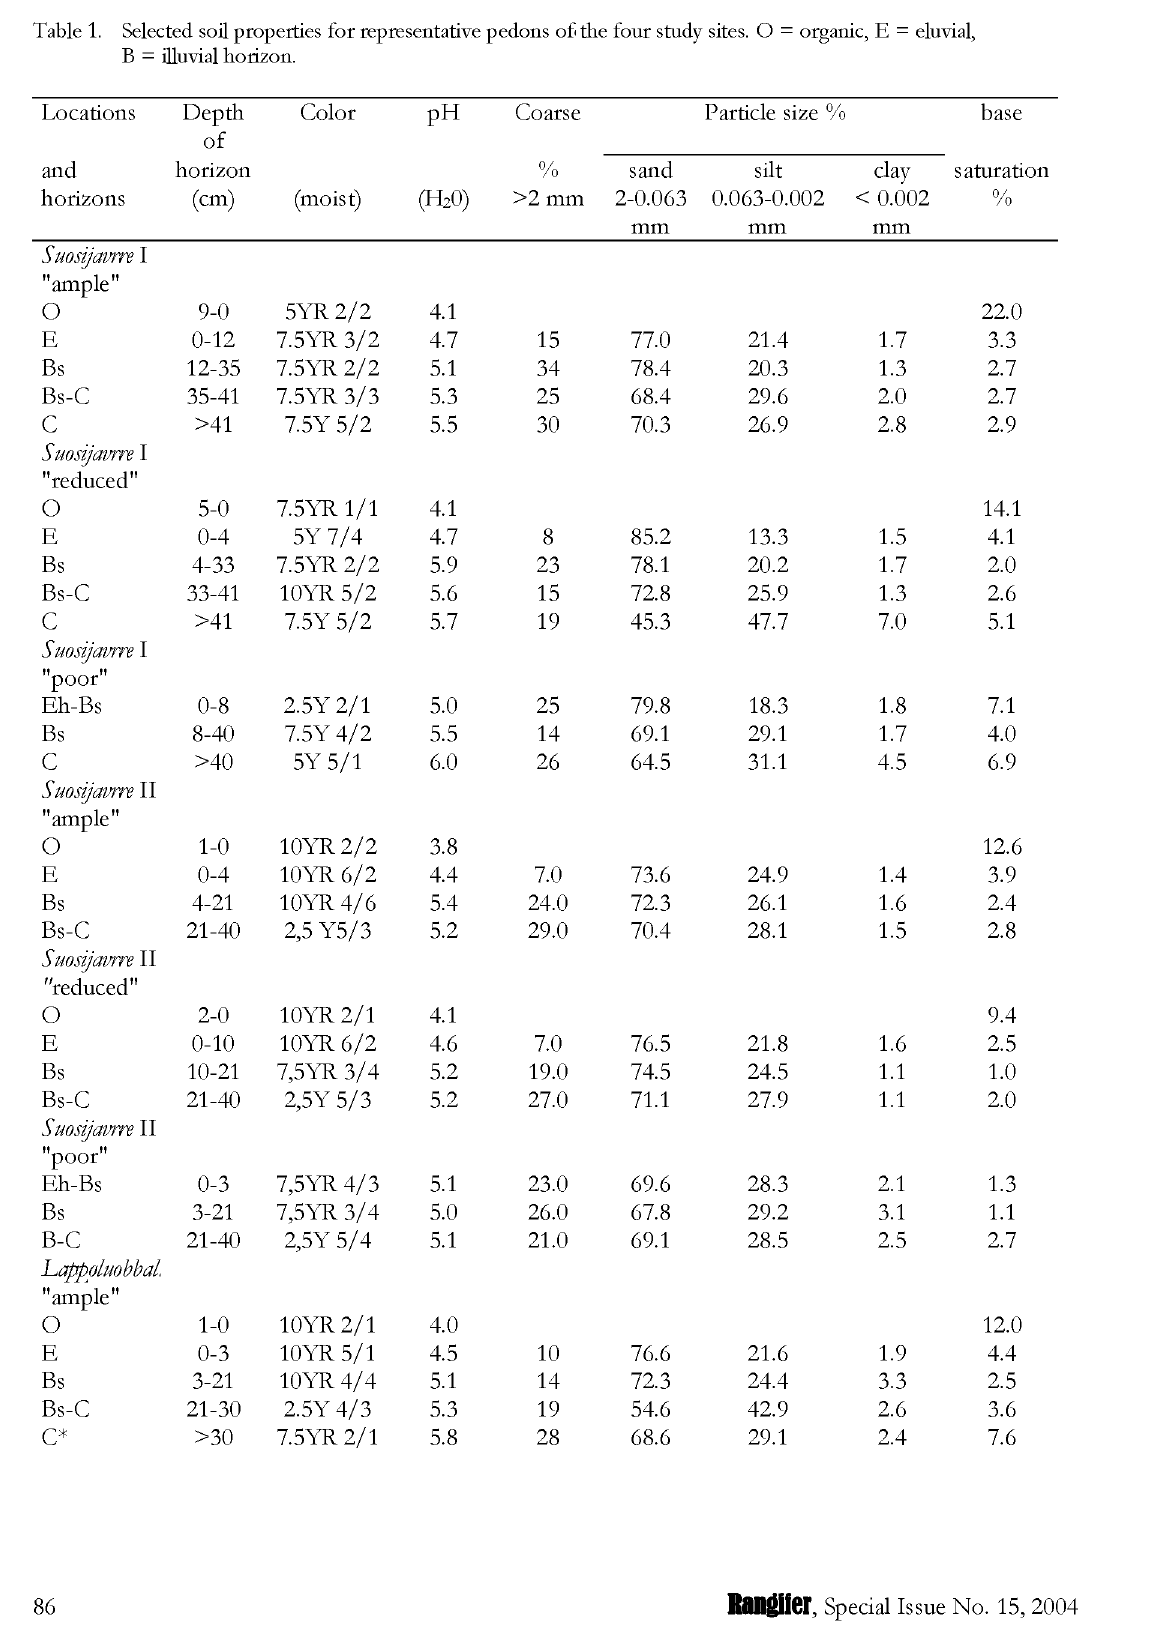
Table 1. Selected soil properties for representative pedons of the four study sites. O = organic, E = eluvial, B = illuvial horizon. Locations Depth Color pH Coarse Particle size % base of and horizon % sand silt clay